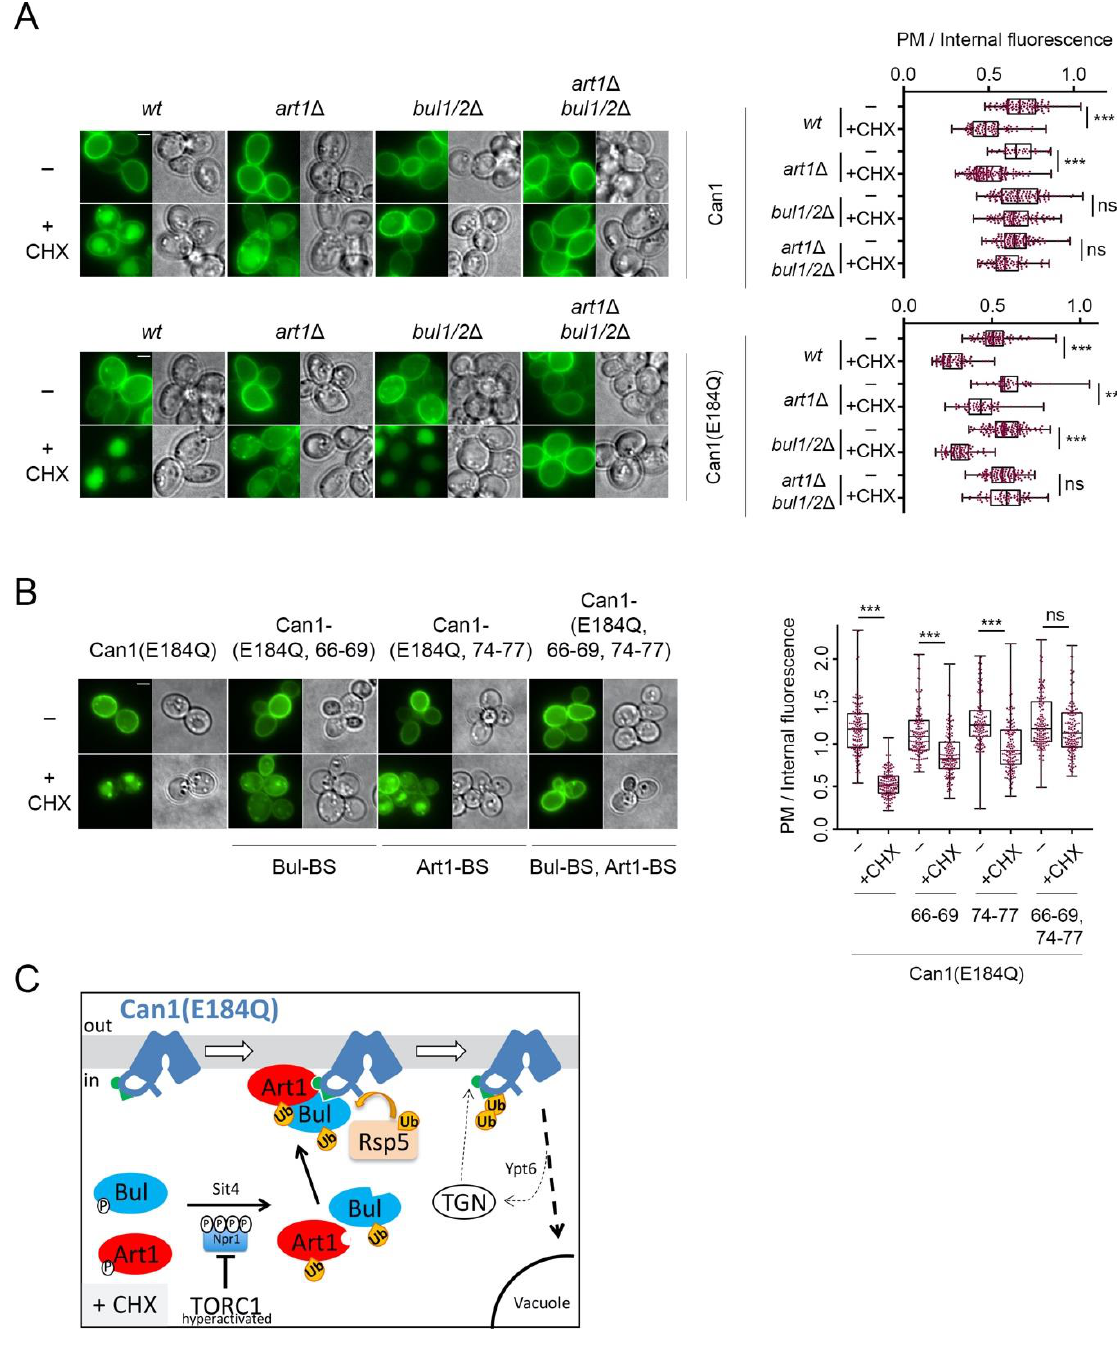
Figure 5. Artificial exposure of the masked Art1-BS at the N-tail of Can1 renders the permease sensitive to TORC1-activated Art1. ( A ) Epifluorescence microscopy of wild type Can1-GFP and Can1(E184Q) -GFP in wt , bul1 / 2 Δ, art1 Δ, and art1 Δ bul1/2 Δ strains. Cells were grown in Gal and Am MM. Glu was added for 1 h followed by addition of CHX for 3 h. Quantifications: Plasma membrane (PM) to internal GFP fluorescence intensity ratios are plotted ( n = 38 – 135 cells). Quantifications, representations and scale bar as in Figure 2A. The quantifications for wt Can1 are the same from Figure 2A, since the experiments have been performed in parallel. ( B ) Epifluorescence microscopy of gap1 Δ can1 Δ cells expressing the indicated Can1 alleles combining E184Q with Ala substitutions in either the Art1-BS (residues 74 – 77), or the Bul-BS (residues 66 – 69) or both. Conditions, quantifications ( n = 128 – 160) and representations as in A. ( C ) Schematic representation of the results concerning the CHX-induced endocytosis of Can1(E184Q). This allele stabilizes Can1 in an Inward-Facing conformation and constitutively exposes the binding site for Art1 (residues 70 – 81, green hemicycle). Upon CHX addition, Can1 is recognized not only by the Bul1/2 (Figure 4E), but also by Art1, leading to more efficient ubiquitylation by Rsp5, endocytosis and degradation.